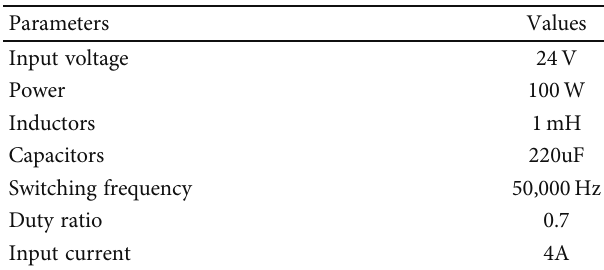
Table 4: Performance